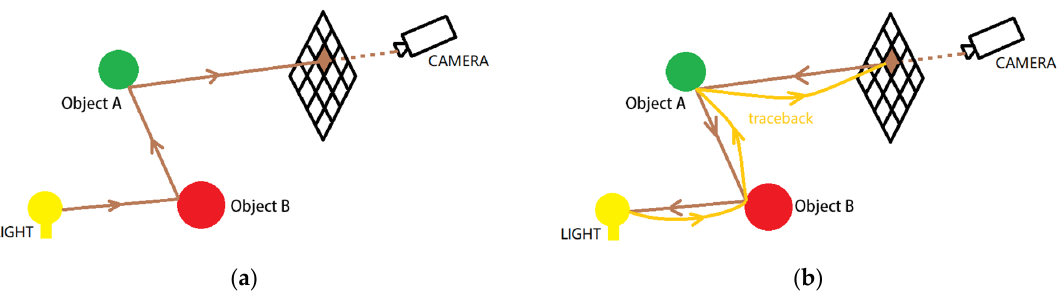
Figure 4. Schematic diagram of ray-tracing algorithm: ( a ) light starts from light source and eventually hits a camera; ( b ) light shines out of the camera and backtracks.